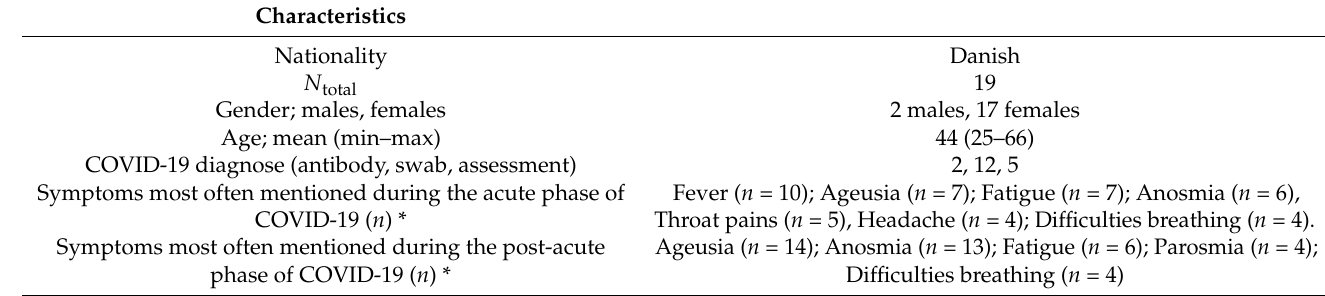
Table 1. Participant